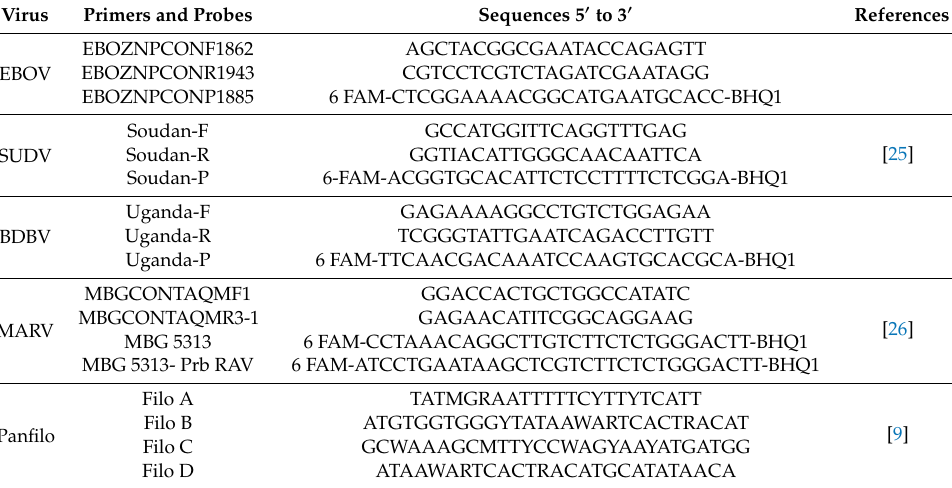
Table 2. Primers and probes used for the detection of the